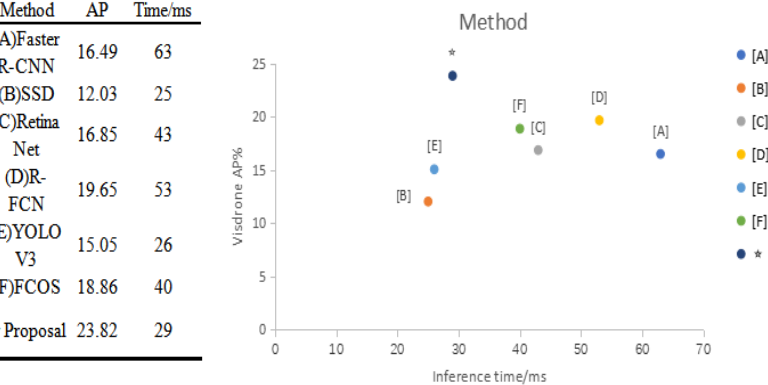
Figure 6. VisDrone test comparison visualization.